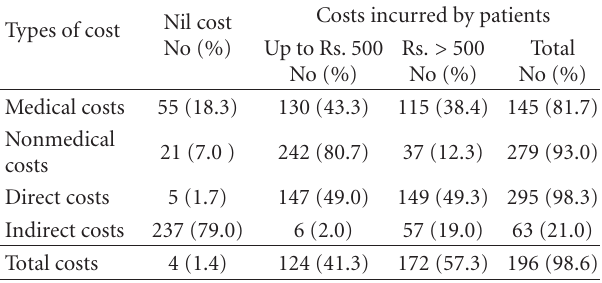
Table 3: Pretreatment costs to patients with TB.